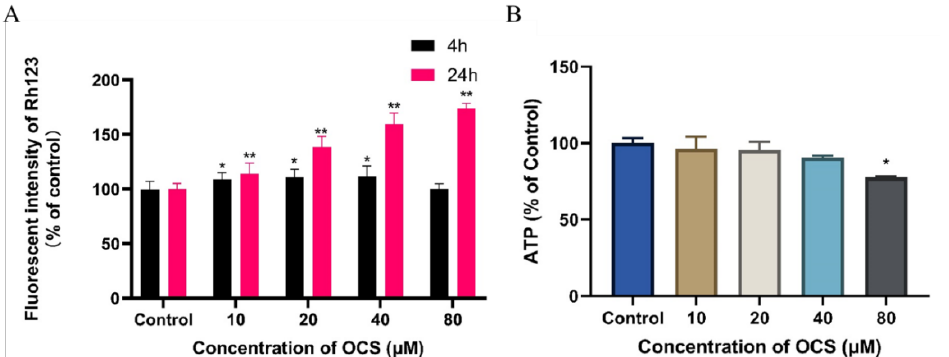
Figure 4. Indicators of mitochondrial dysfunction in HepG2 cells following OCS exposure for 24 h; ( A ) increase in MMP after treatment with OCS in HepG2 cells; ( B ) OCS decreased the generation of ATP in HepG2 cells. Values are mean ± SD of three independent experiments ( n = 3) (* p < 0.05, ** p < 0.001 vs. control).